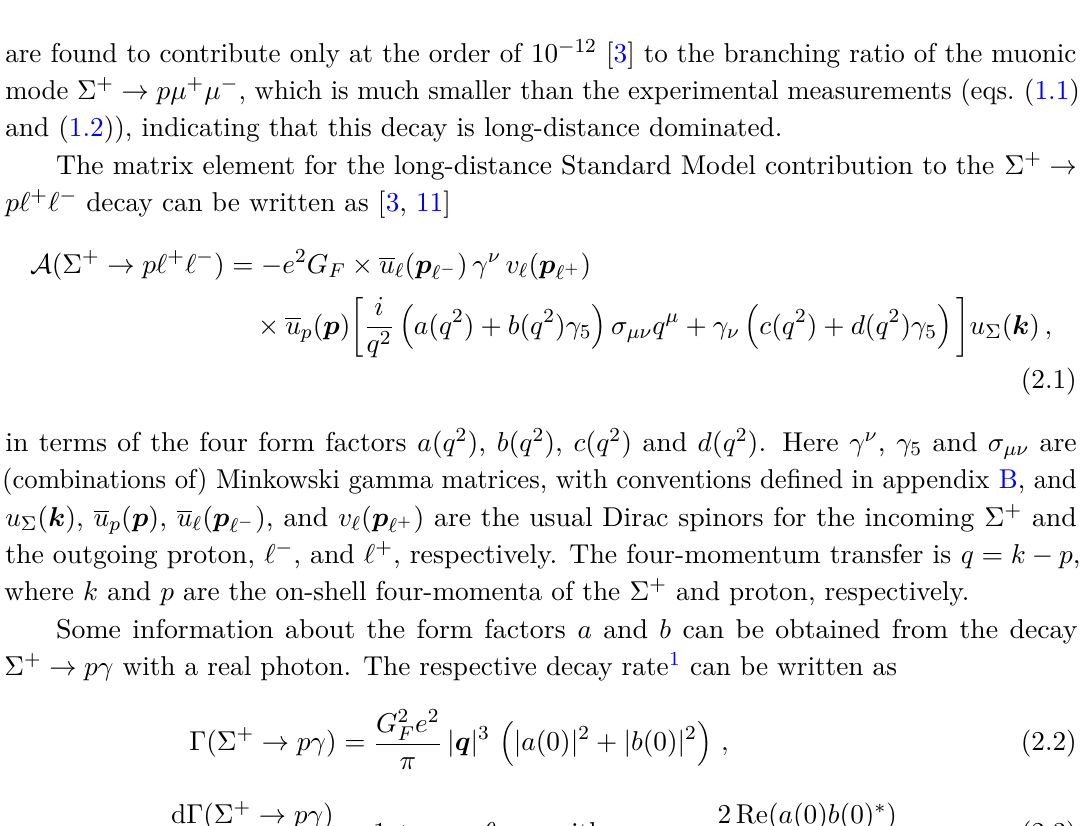
Figure 1 . Short-distance Standard Model contributions to the s → d transition from penguin and box